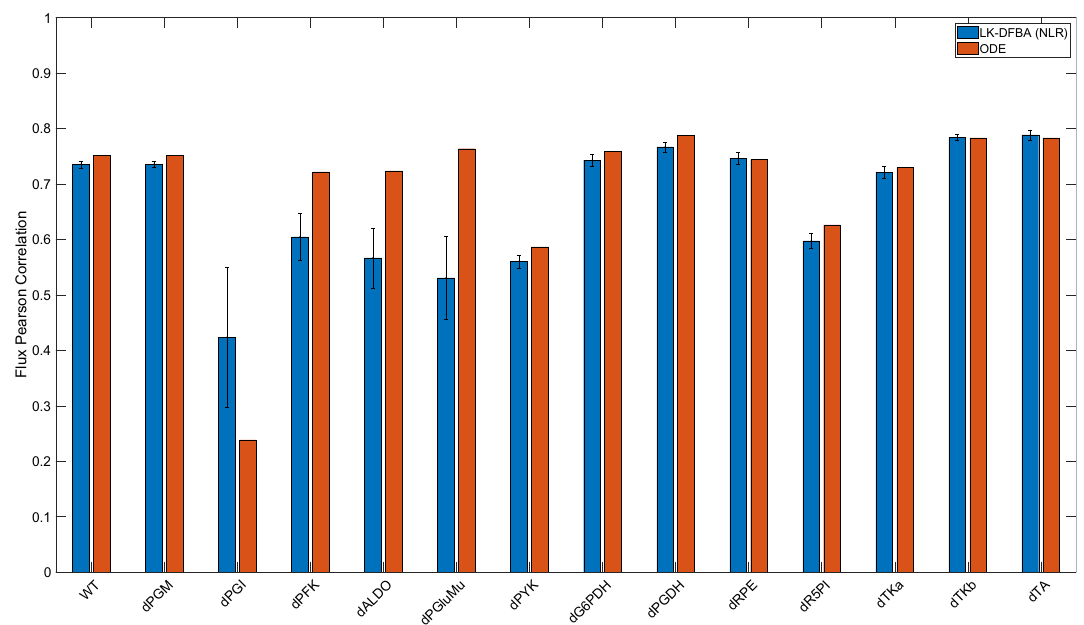
Figure 5. Pearson correlation coefficients of LK-DFBA and ODE model flux predictions with E. coli experimental data. LK-DFBA (NLR) was the best approach when fitting on low sampling frequency (nT = 15) and high noise (CoV = 0.15) data. Blue and red bars represent LK-DFBA (NLR) and ODE model mean correlations, respectively, between the average predicted flux profiles and experimental steady-state flux data for the wildtype system and various gene knockout conditions. Gene knockouts in the LK-DFBA and ODE-based models were simulated by down-regulating relevant pathways. Error bars for LK-DFBA represent one standard deviation (N = 10